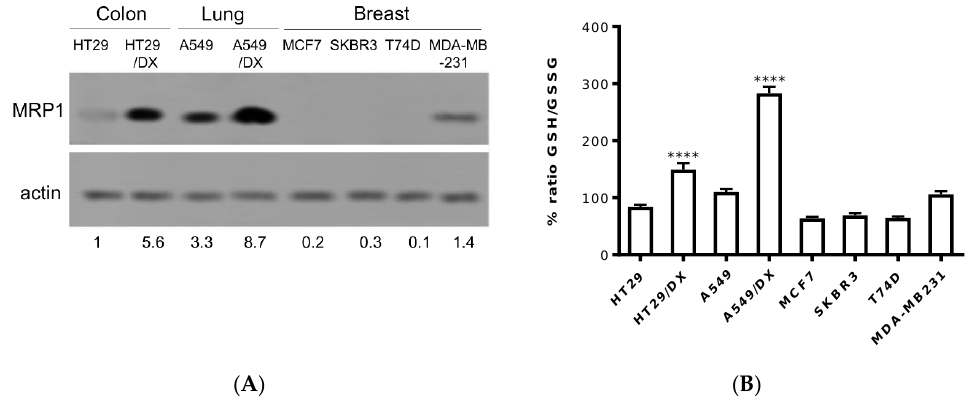
Figure 2. MRP1 expression checked by Western blotting in different cancer cell lines: A549/DX > HT29/DX > A549 > HT29 = MDA-MB-231 > MCF7 = SKBR3 = T74D ( A ): Histogram